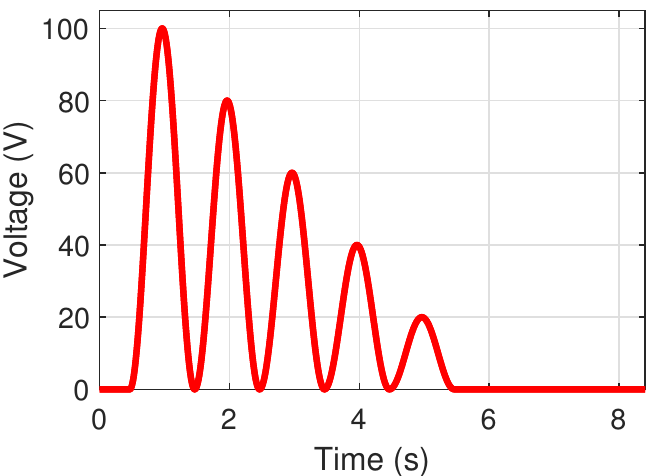
Figure 11. Experimental driving voltage with varying amplitude.